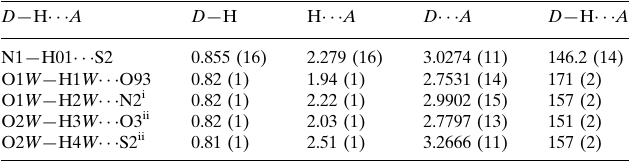
Hydrogen-bond geometry (A˚ , (cid:3)